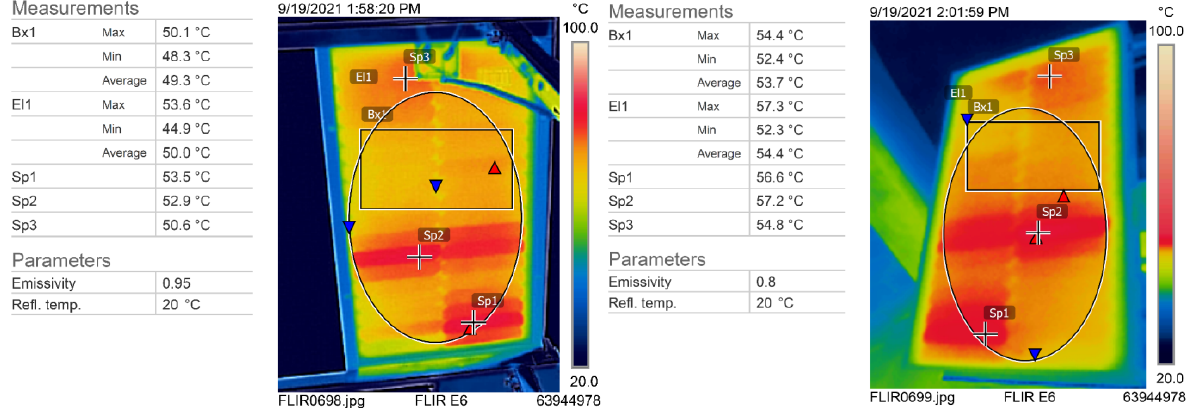
Figure 9. Pilot module thermogram recorded with the FLIR E6 camera: bottom side ( left ), top side ( right ).